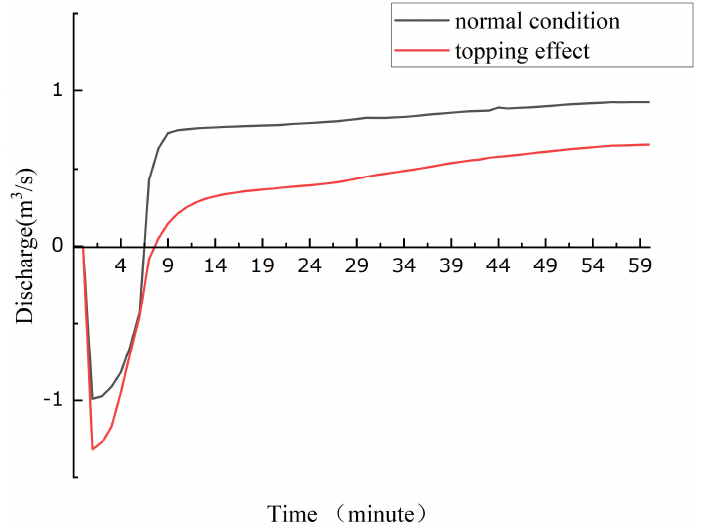
Figure 9. Comparison of discharge flow at the Daqing Road outfall before and after the water level rises under condition A.